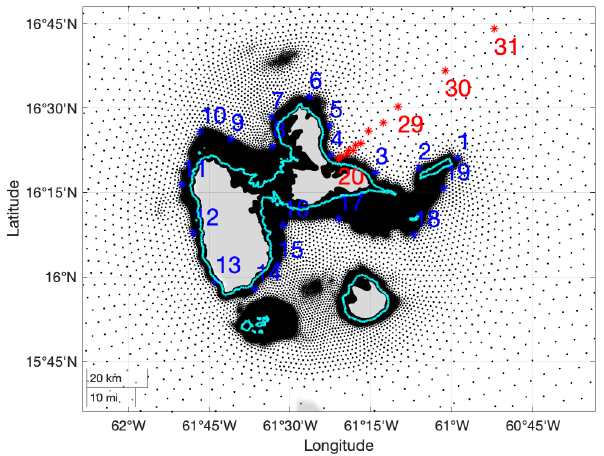
Figure 2. Illustration of the Guadeloupe archipelago (administra- tive boundaries are outlined in light blue), showing calculation grid points (black dots), the selected numbered locations along the iso- depth contour at 100m (blue stars), and line transect (red stars). Cal- culation grid points are more dense in shallow waters. Water depths along the line transect with locations numbered 20–31 are 58, 235, 543, 754, 819, 1206, 1513, 2350, 3265, 4059, 5074, and